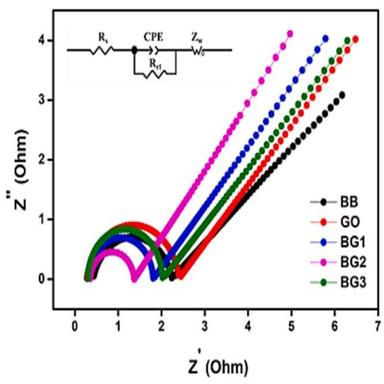
Nyquist plot BB, GO, BG1, BG2 and BG3 with equivalent circuit model.